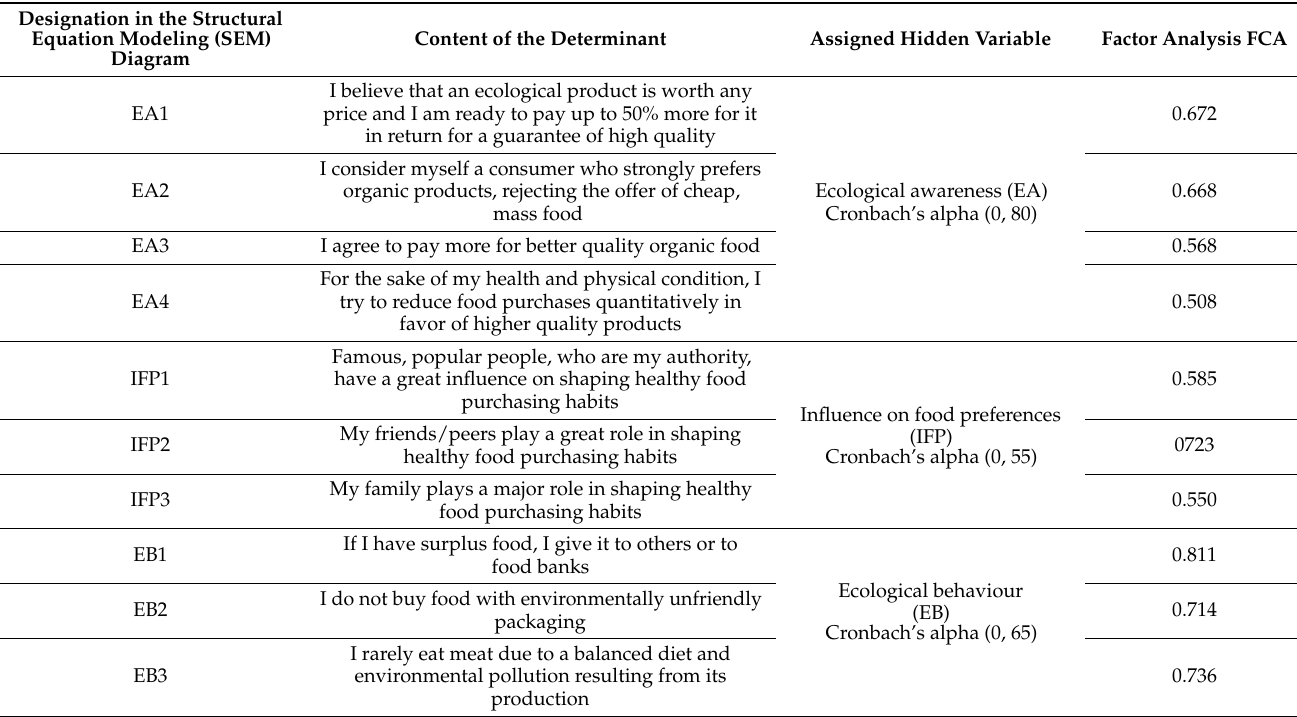
Table 2. Operationalization of hidden